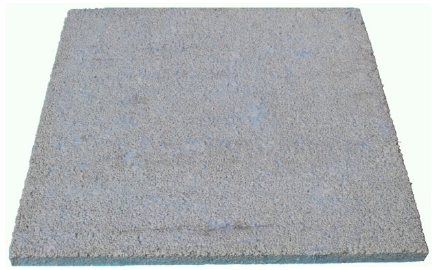
Figure 3. External view of prepared PCMP.